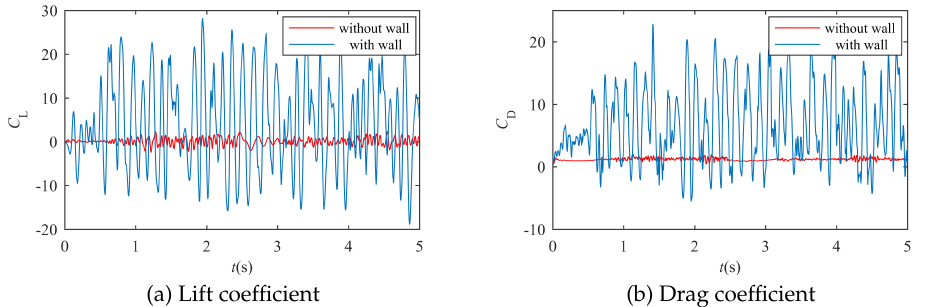
Fig. 6. Time history diagram of aerodynamic coefficient variation of positive feeder